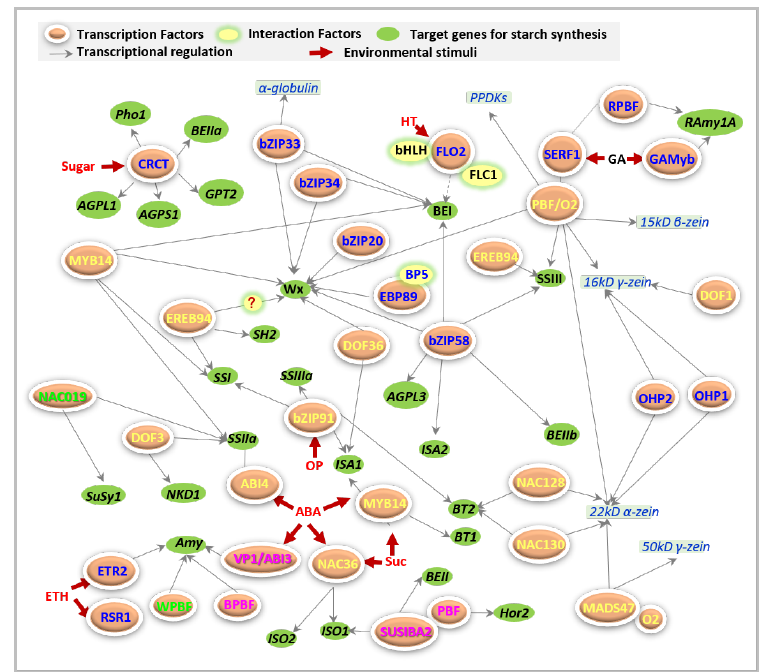
Figure 1. Overview of the regulators of starch metabolism in cereal crops. The figure was created based on the published literature (until 28 August 2021). The reported regulators and their target genes from different cereals were collected to build potential regulatory networks of starch metabolic genes. Starch biosynthesis involves a great deal of enzymatic and non-enzymatic proteins, which constitutes a very complex network. This process requires many regulators to match the providential functioning of these starch biosynthetic enzymes. Nowadays, dozens of transcription factors have been reported to directly regulate starch synthesis, i.e., bZIP58, NAC019, MYB14, FLO2, SUSIBA2, and so on. Besides, some regulators also control starch synthesis through the formation of proteins and sucrose, including MADS47, DOF1, and so on. Various regulators prefer to be activated in response to different fluctuating environments, such as hormone levels (i.e., ethylene, ETH; abscisic acid, ABA; gibberellin, GA), osmotic pressure (OP), sugar (i.e., sucrose, SUC), and high temperature (HT), etc. Regulators that exist in rice, maize, wheat, and barley are shown in blue, yellow, purple, and green color letters,